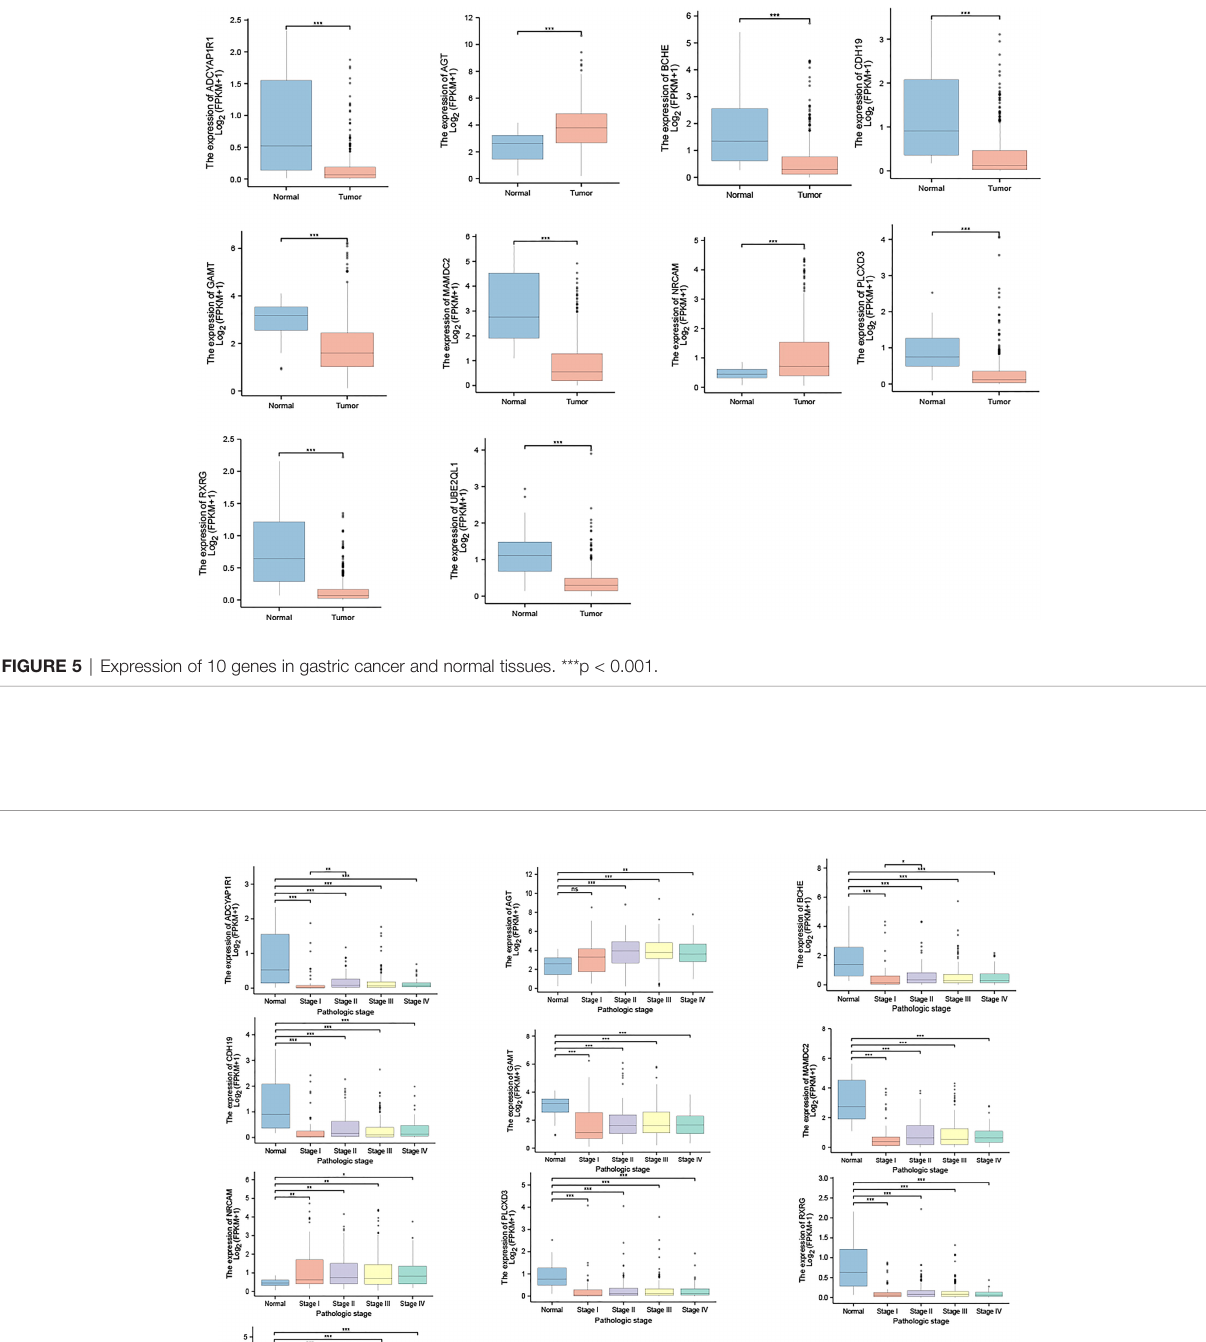
Frontiers in Oncology |